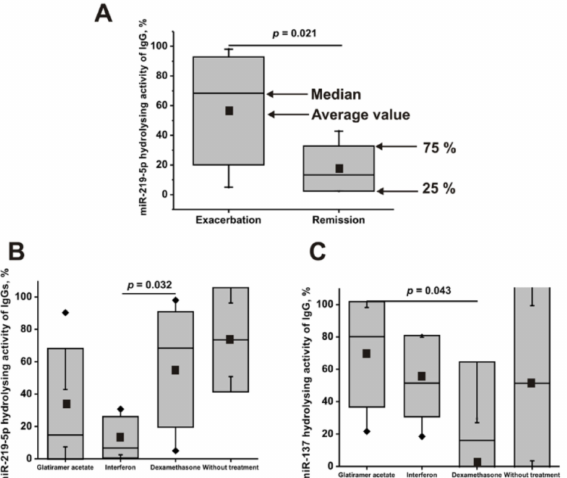
Figure 7. Comparison of the average values of relative activities ( (cid:4) ), medians ( __ ), and interquartile IQR ranges (gray areas) for groups of patients with exacerbation and relaxing courses of MS ( A ), as well as average activities of antibodies corresponding to groups of patients before (2 patients) and after their treatment with dexamethasone (10 patients), glatiramer acetate (5 patients), and interferon β -1b (5 patients) in the hydrolysis of miR-155-5p ( B ) and miR-137 ( C